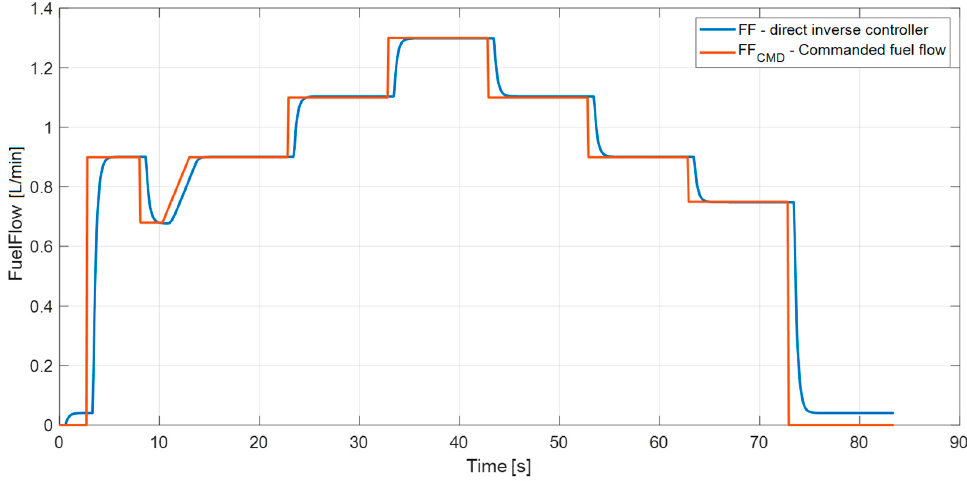
Figure 7. Direct inverse control—dynamic simulation.